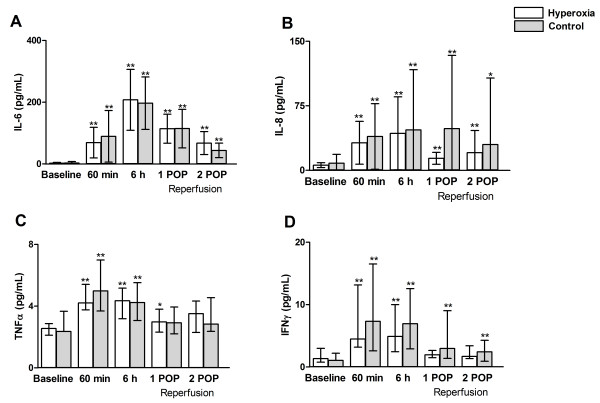
Concentrations of proinflammatory cytokines (IL-6 – panel A, IL-8 – panel B, TNFα – panel B, IFNγ – panel D) at baseline, 6 h after declamping the aorta and in the 1stand 2ndpostoperative mornings (POP). Data are given as mean (SD) – panels A, B and as median (interquartile range) – panels C, D. ** p < 0.01 in comparison with baseline, * p < 0.05 in comparison with baseline.